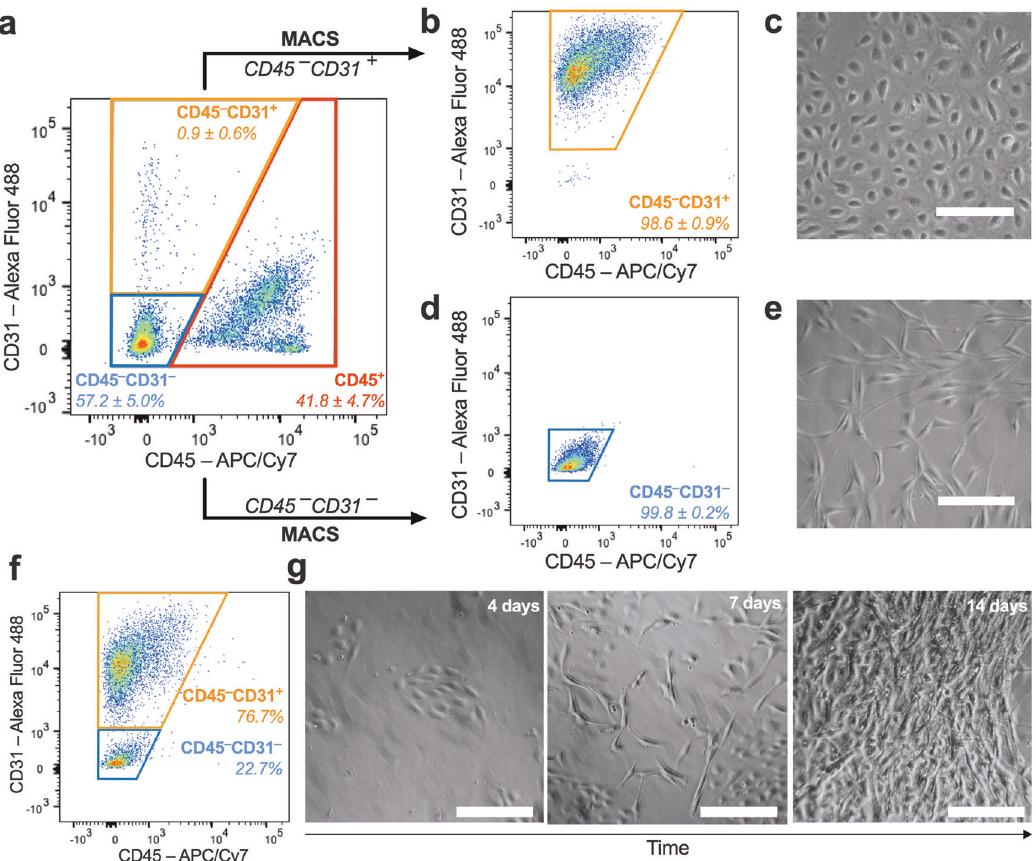
Fig. 1 Primary cultures of human adipose tissue-derived microvascular endothelial cells (HAMVECs) are often overgrown by residual adipose tissue- derived stromal/stem cells (ASCs) from the magnet-assisted cell sorting (MACS) procedure. The stromal vascular fraction of enzymatically digested human subcutaneous abdominal white adipose tissue ( a ) was depleted of CD45 + leucocytes prior to positively selecting for CD31 expression to establish primary cultures of CD45 − CD31 + HAMVECs ( b , c ). Their primary cultures were often overgrown by residual CD45 − CD31 − ASCs from the MACS procedure despite sequential enrichments for CD31 expression ( f , g ), prompting the retention of ASCs for downstream studies ( d , e ). Shown are representative pseudocolour plots depicting the composition of the different populations of cells ( a , b , d , f ), as well as representative photomicrographs depicting their corresponding morphologies ( c , e , g ). Scale bars represent 200 µ m; values mean ± standard deviation. While the isolation of HAMVECs was initially attempted from twenty patients ( n = 20 biologically independent samples), only three cultures were visibly free of stromal cell overgrowth ( n = 3 biologically independent samples); in the other 17 patients, cultures were visibly overgrown by stromal cells within 2 weeks ( n = 17 biologically independent samples). The composition of the different populations of cells was assessed in three patients in all but visibly contaminated primary cultures of HAMVECs ( a , b , d ; n = 3 biologically independent samples), in which fl ow cytometry was used to elucidate the identity of the contaminating stromal cells rather than to assess their purity ( f ; n = 1 biologically independent